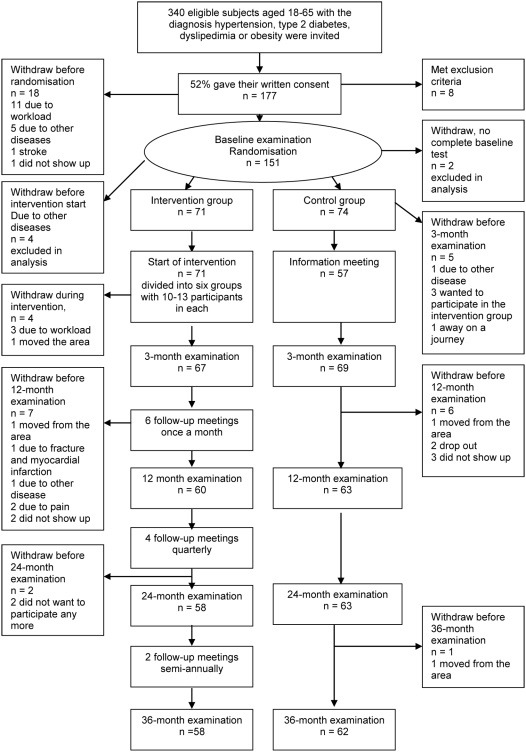
Participants flow Diagram.